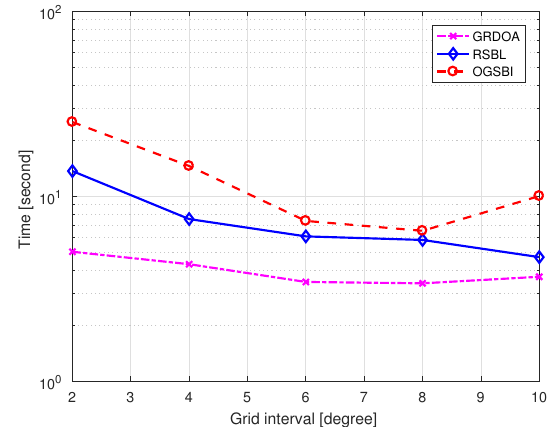
Figure 7. Computational time versus grid interval with SNR = 10